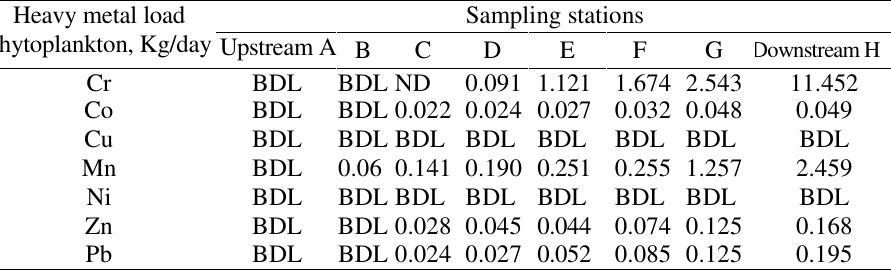
Table 5. Heavy metal concentrations in phytoplanktens (mg/kg) in various sampling